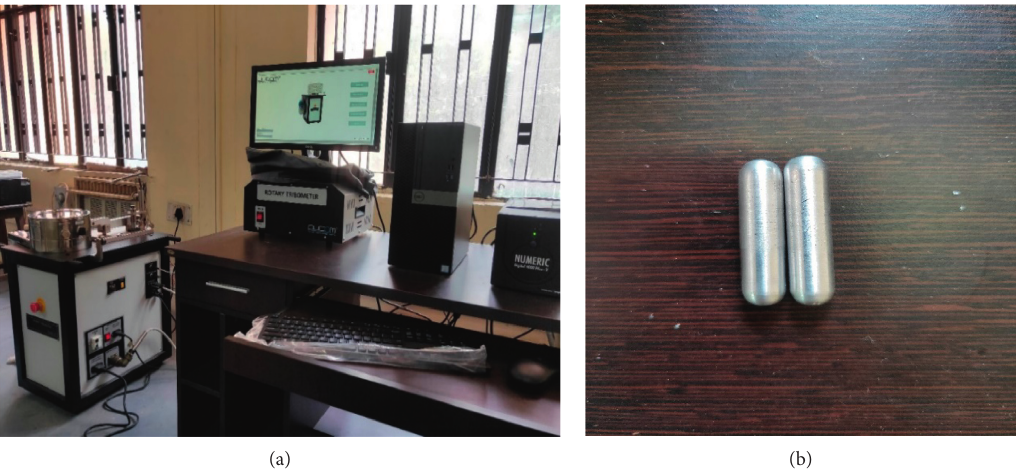
Figure 3: (a) Pin-on-disc advanced rotary tribometer and (b) specimens for the wear